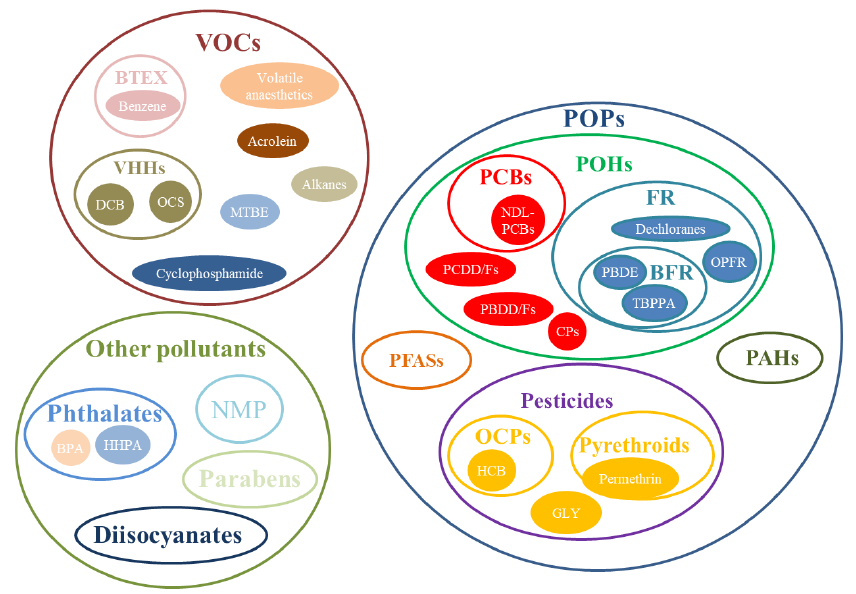
Figure 3. Classification of airborne hazardous pollutants.